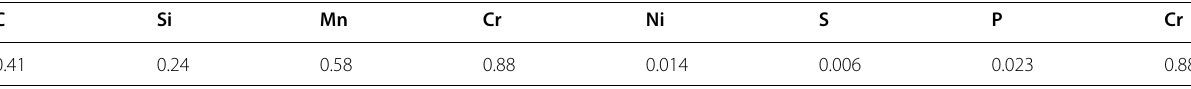
Table 1 Chemical composition of the steel (wt%)